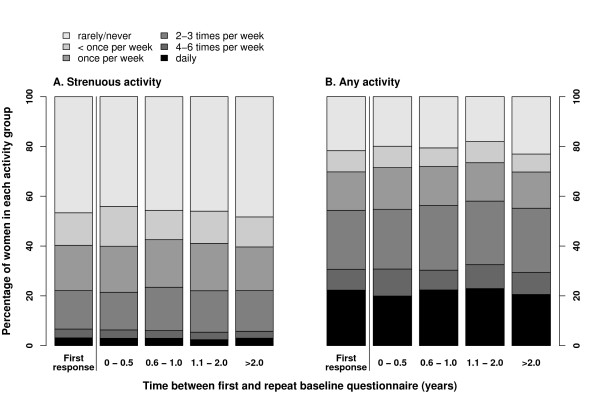
Distribution of reported frequency of physical activity by time between first and repeat baseline questionnaires. Shaded regions indicate proportions of women reporting the various frequencies of physical activity, either at baseline, or at repeat administration of the questionnaire stratified by the time between first and repeat responses.